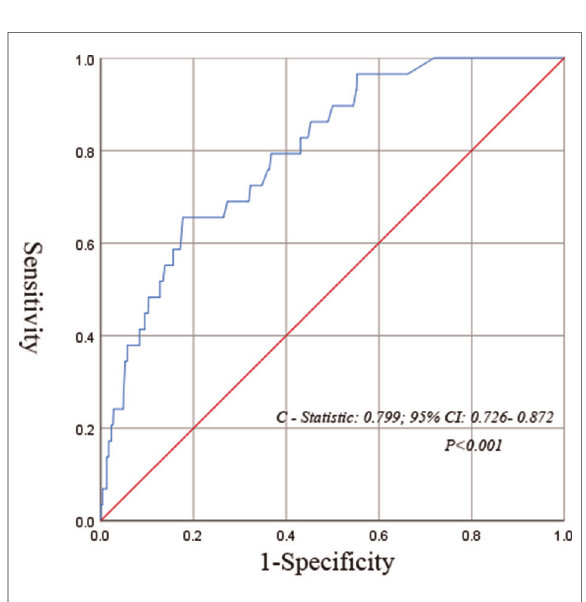
FIGURE 2 C-statistic revealing the discriminative power of the multivariable logistic regression model for prediction of postoperative unplanned ICU admission.